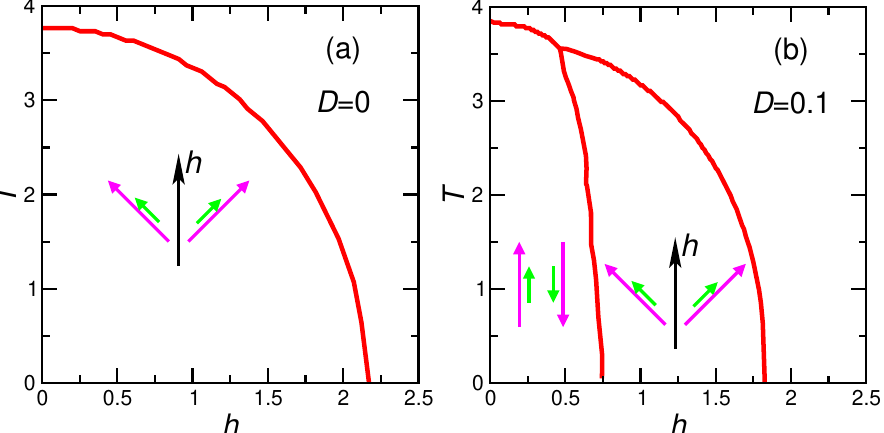
Figure A3. Single-site mean-field phase diagrams for J = 1, J ⊥ = 0.5, and D = 0 ( a ) and for D = 0.1 ( b ). The schematics indicate the spin configurations relative to the applied magnetic field in the ordered phases. A pair of parallel arrows indicates Mn (magenta) and Ni (green) spins in one chain; the second pair indicates the neighboring chain. The phase at high temperatures or large magnetic fields is